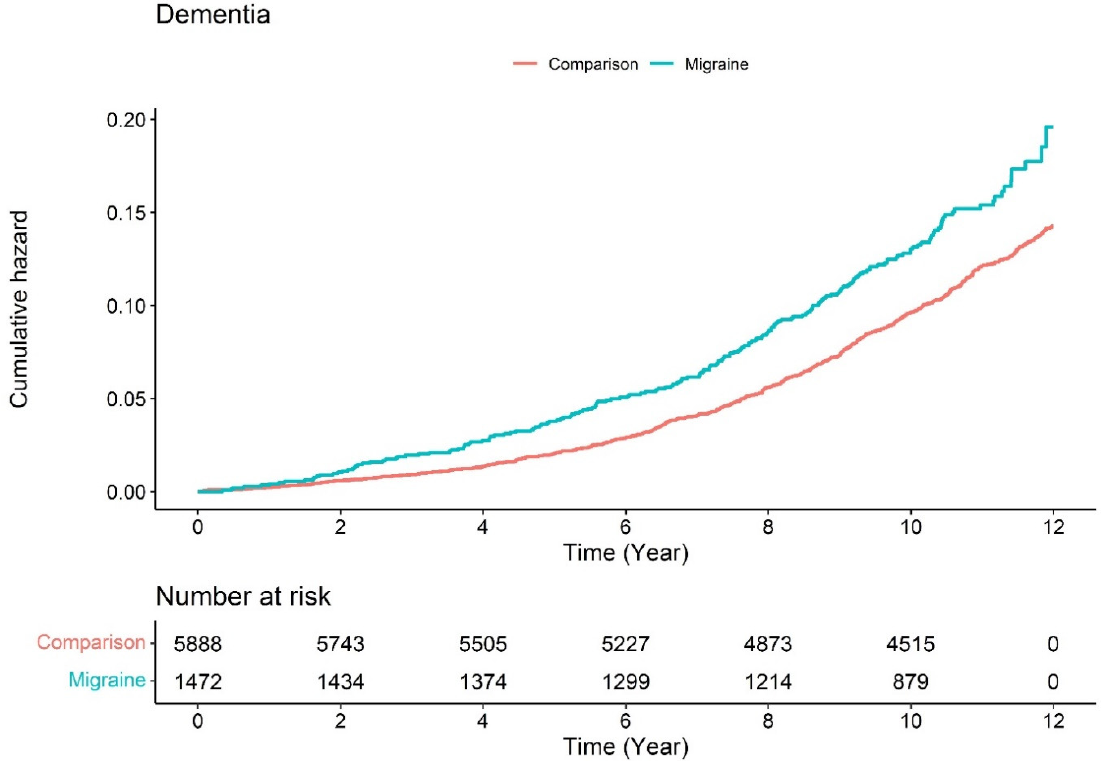
Figure 3. Cumulative hazard plot of specific between migraine and comparison (participants without migraine).